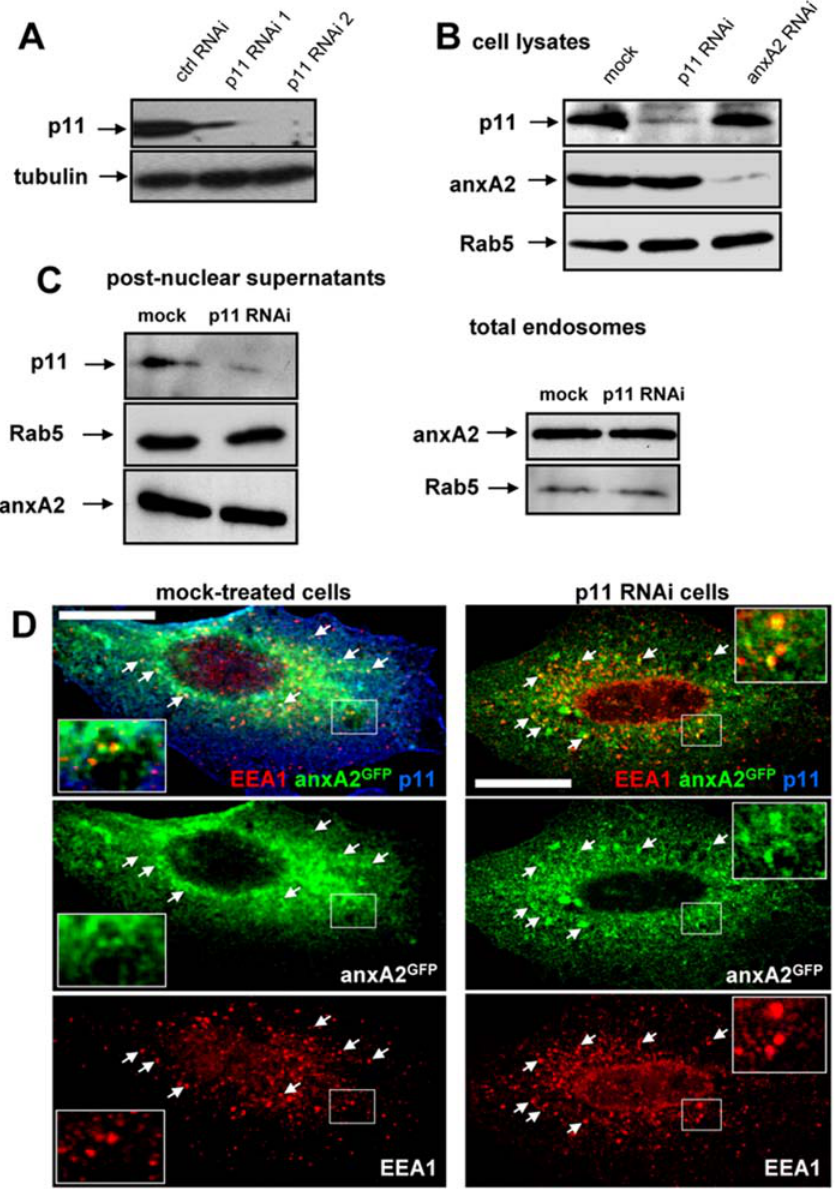
Figure 5. endosomal targeting of annexin A2 is not affected when p11 is downregulated. (A) p11 was downregulated in HeLa cells using two siRNA duplexes (RNAi1 and RNAi2), and lysates were prepared. The control (ctrl RNAi) siRNA used was designed against viral stomatitis virus (VSV-G) G-protein, which is not expressed in HeLa cells; equal amount of proteins were loaded in each lane and tubulin was used as an equal loading marker. (B) AnxA2 (diced AnxA2 RNAi) or p11 (RNAi2) was downregulated in HeLa cells, and total lysates were analyzed by western blotting as indicated (C) p11 was knocked down (as in A–B), and then a post-nuclear supernatant was prepared (left panel) and used as to further fractionate total endosomes (right panel). The samples were then analyzed by western blotting using the indicated antibodies. (D) AnxA2-GFP (AnxA2 H28 -GFP) was expressed in mock-treated (left panel) or p11-siRNA2-treated HeLa cells (right panel) and then cells were processed for immunofluorescence as in Fig 1 (using the special permeabilizaiton protocol). Arrows show AnxA2-GFP/EEA1 colocalizations and cropped images are shown under both conditions. Bar: 10 m